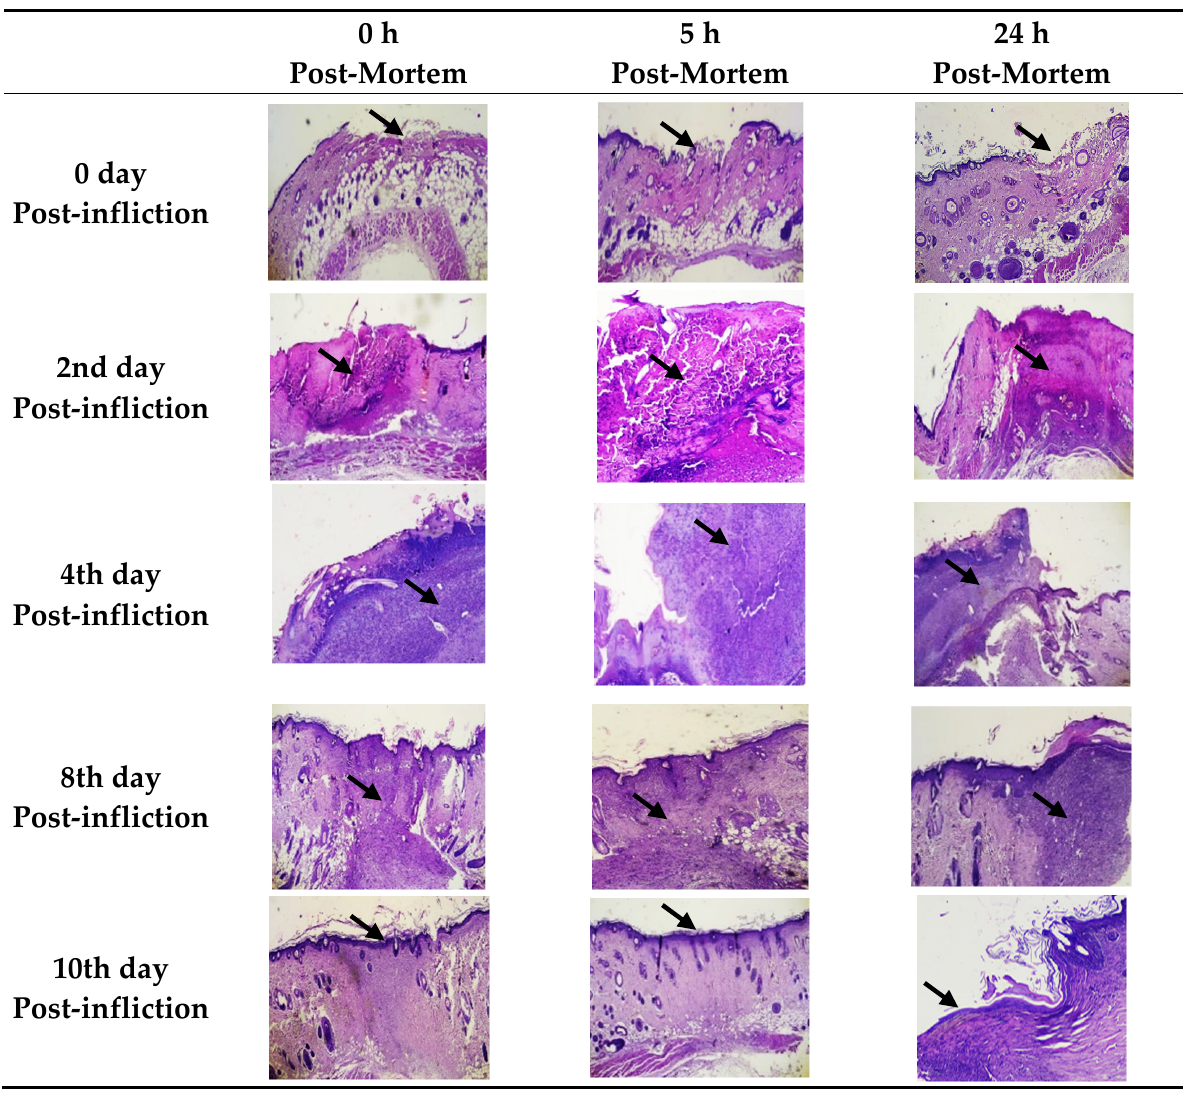
Figure 2. Photomicrograph of wound healing progression (40× magnification) in day 0, day 2, day 4, day 8, and day 10 post-wounding at different postmortem intervals (0, 5th, and 24th hours). Day 0 showed epidermal ulceration (arrow) with mild dermal edema, while on the 2nd day, there were moderate edema, congestion and inflammatory cellular infiltrate with mid fibroplasia (arrow). On the 4th day, wounds showed marked edema, congestion and inflammatory cellular infiltrate with moderate fibroplasia (arrow) and early attempts of re-epithelialization, and on the 8th day, it showed mild to moderate edema, congestion, and inflammatory cellular infiltrate with moderate fibroplasia (arrow) and near complete re-epithelialization. On the 10th day, wounds showed com- plete re-epithelialization (arrow) with disappearance of inflammatory parameters. No obvious change was detected at different early post-mortem intervals. Table 1. Scoring of histopathological findings of injured cutaneous samples.